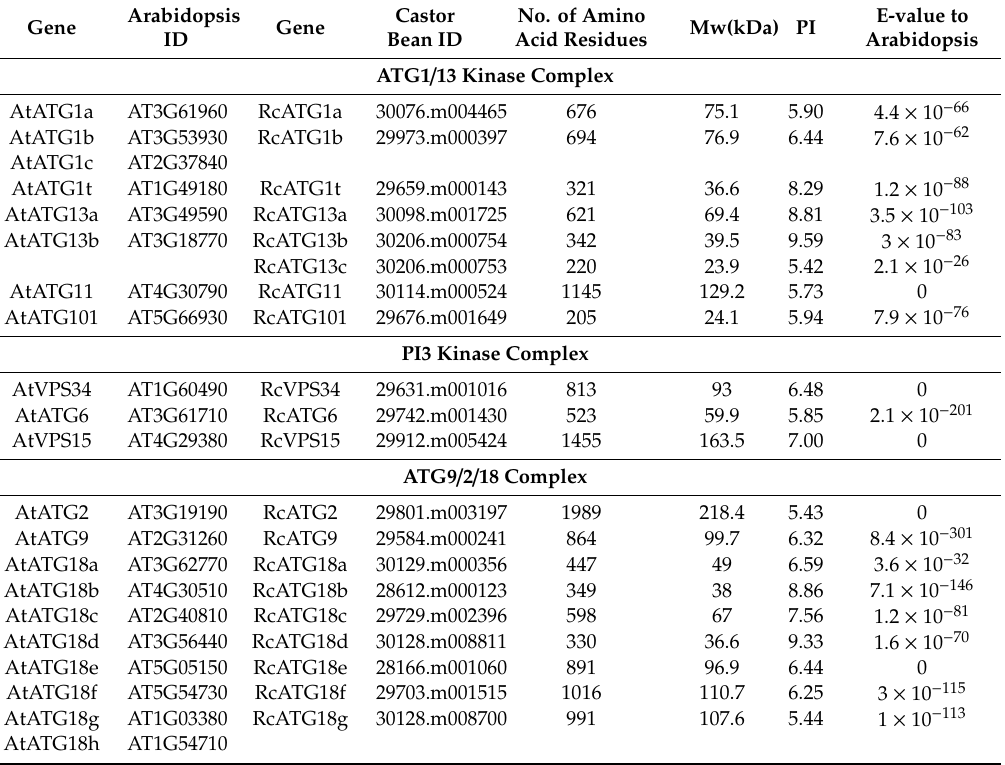
Table 1. The ATGs in castor